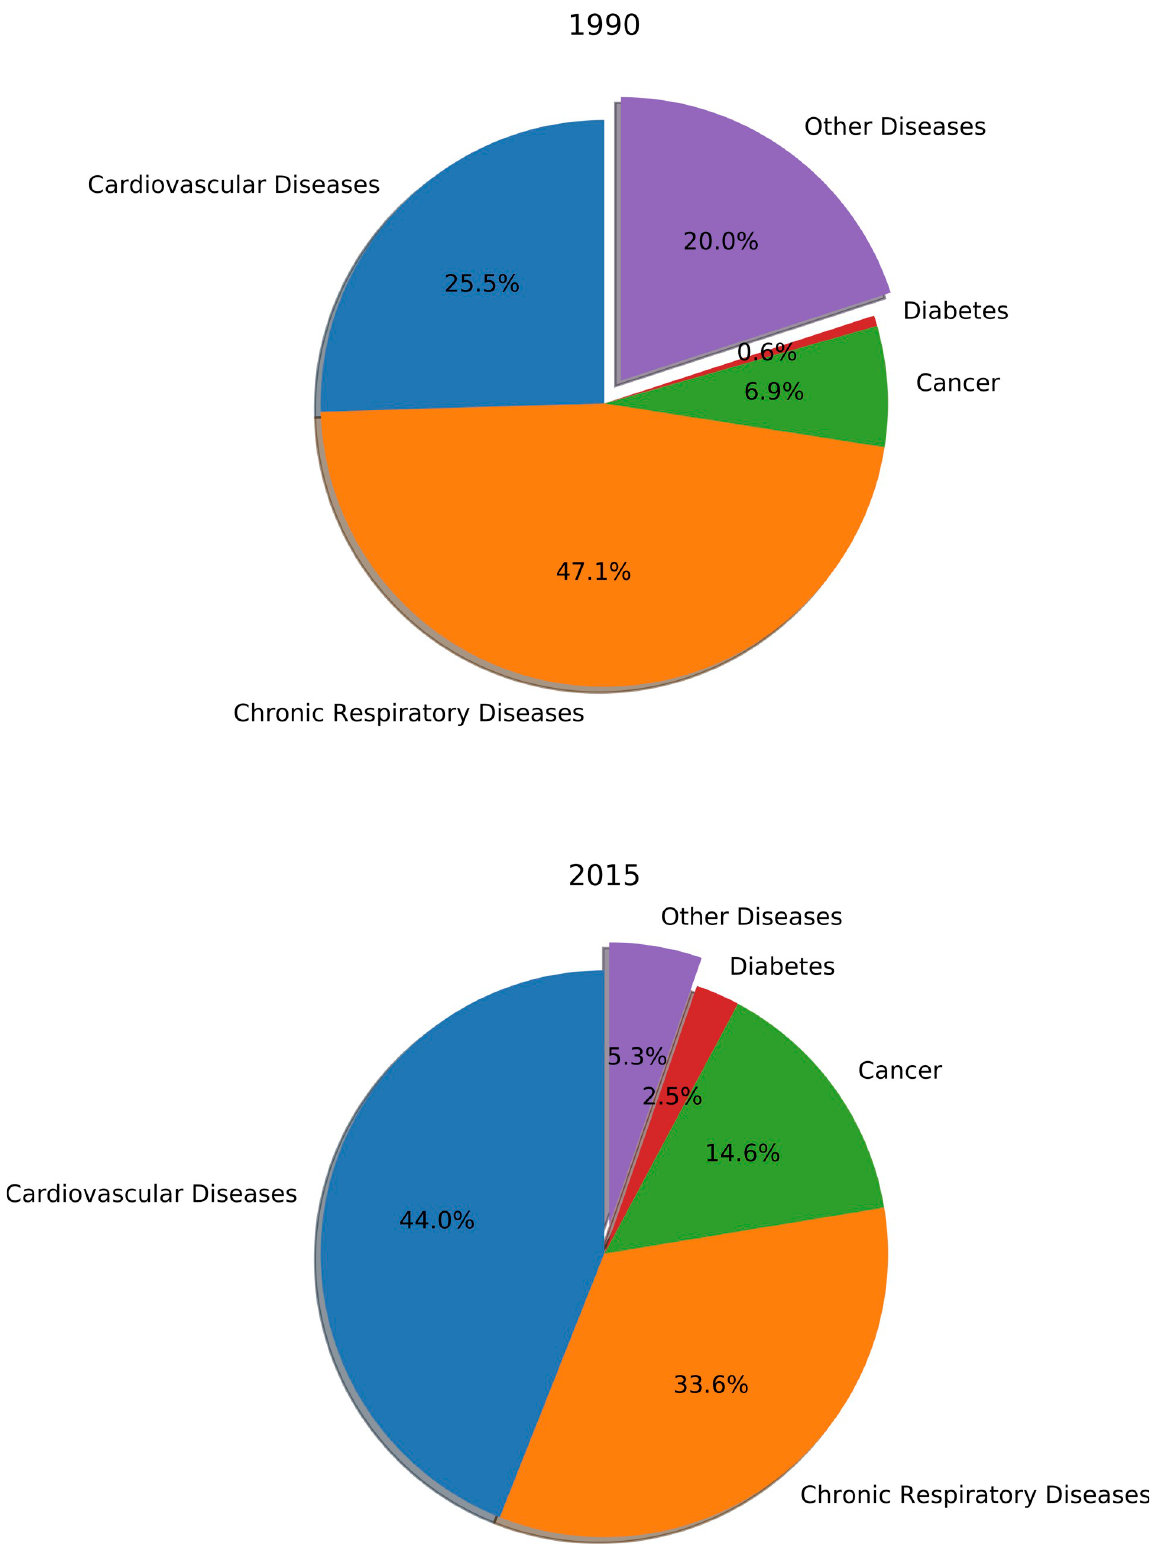
Fig 2. Percentage of deaths caused by air pollution by disease categories.